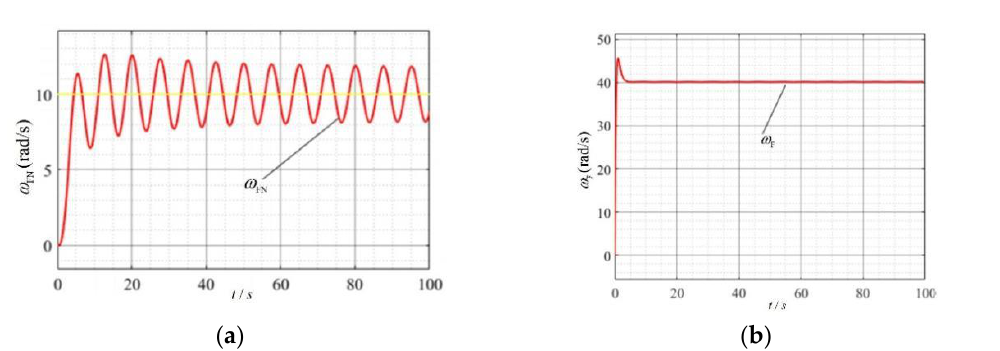
Table 7. Two schemes and conclusions of periodic vibration of drivetrain.